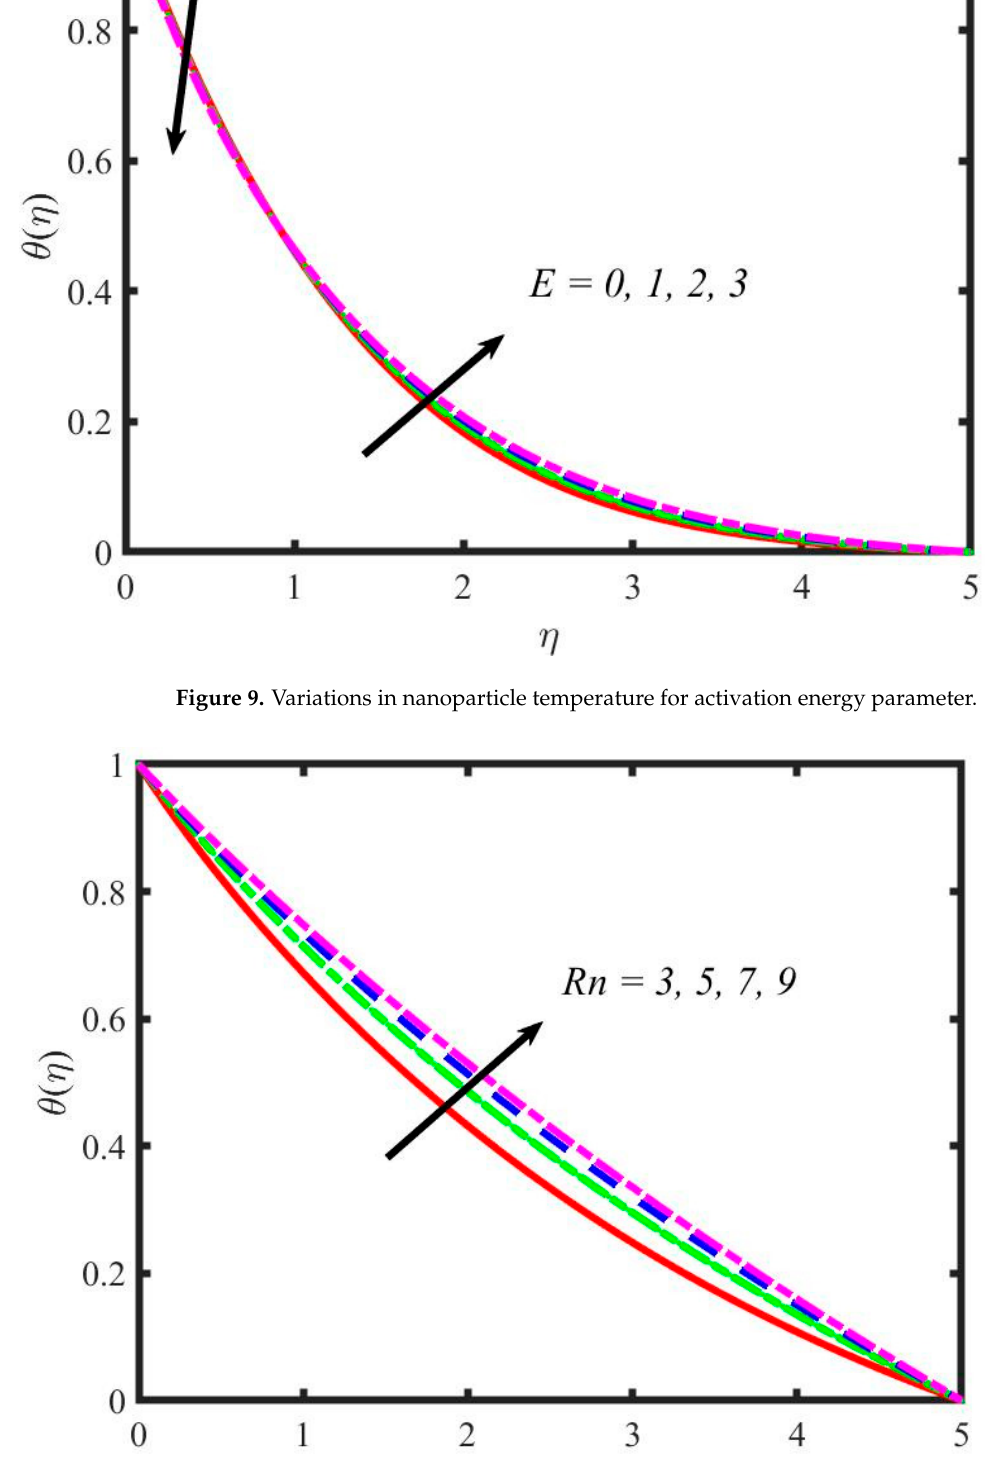
Figure 10. Variations in nanoparticle temperature for radiation parameter.